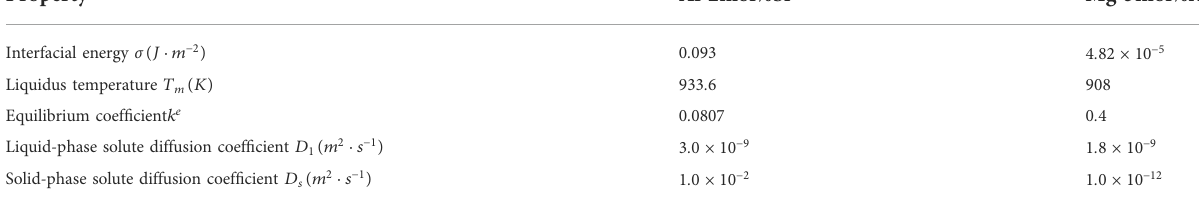
TABLE 1 Thermophysical data of